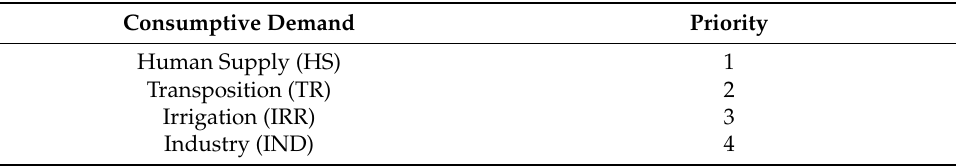
Table 4. Operational restrictions downstream studied